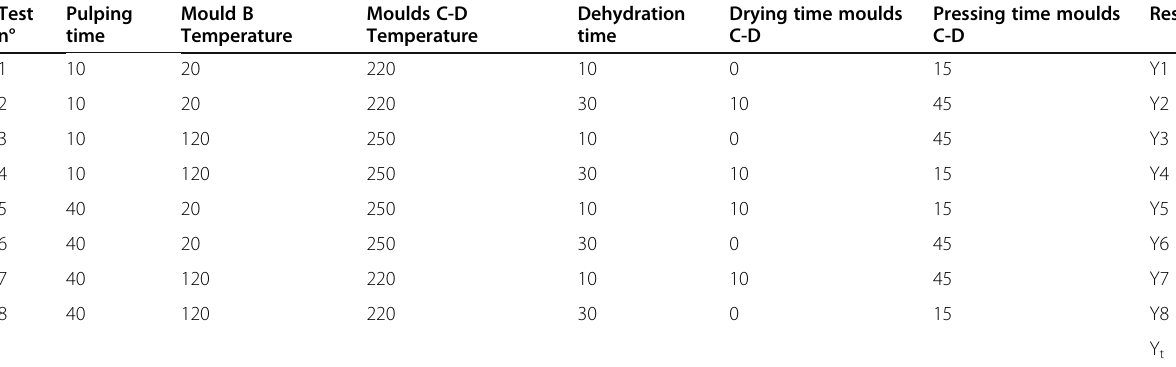
Table 2 Taguchi table used to optimize the number of experimental runs Test n°